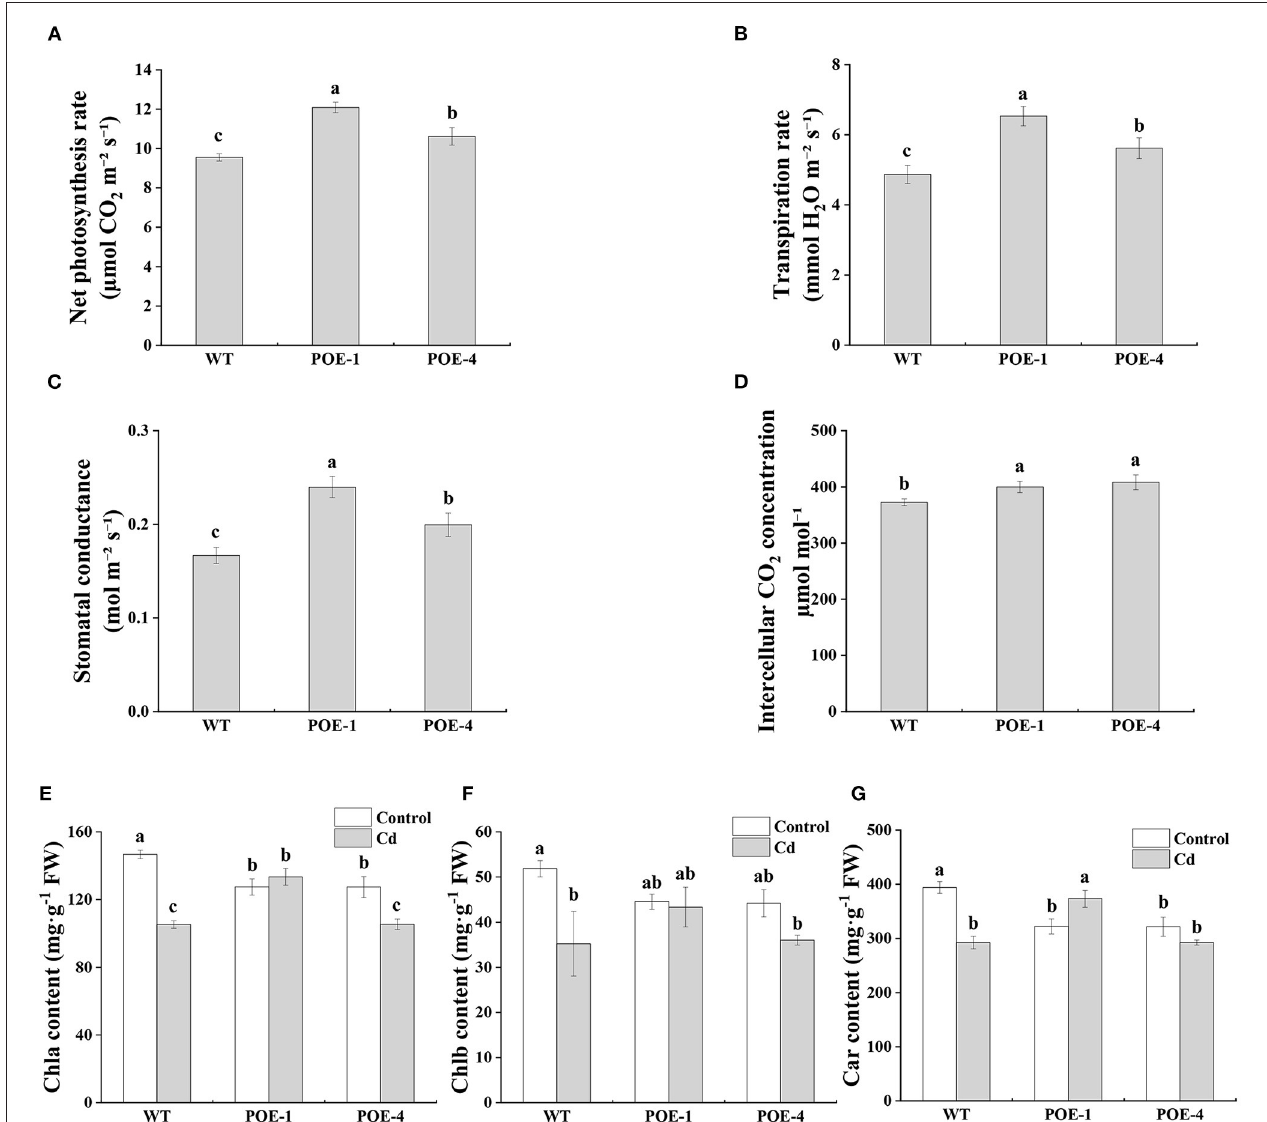
FIGURE 5 | The effect of PscCYP716A1 on poplar photosynthesis under Cd stress. (A–D) Net photosynthetic rate, transpiration rate, stomatal conductance, intercellular CO2 concentration under Cd stress. All data are represented as mean ± SD of three biological duplicates. Significant differences between WT and PscCYP716A1 -overexpressed lines are indicated by different letters. (E–G) Chlorophylla content, chlorophyllb content, and carotenoid content. All data are represented as mean ± SD of three biological duplicates. Columns with at least one same letter are not significantly different ( p <